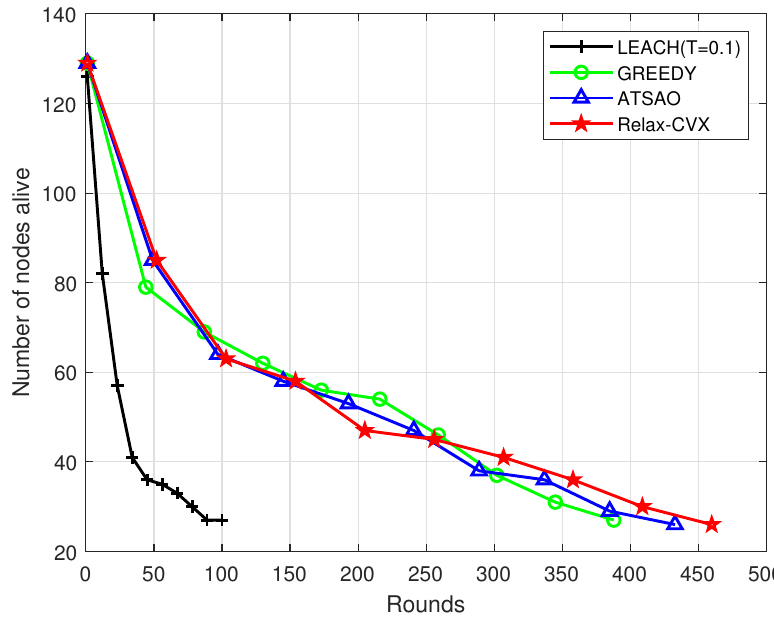
Figure 6. Number of nodes alive versus number of